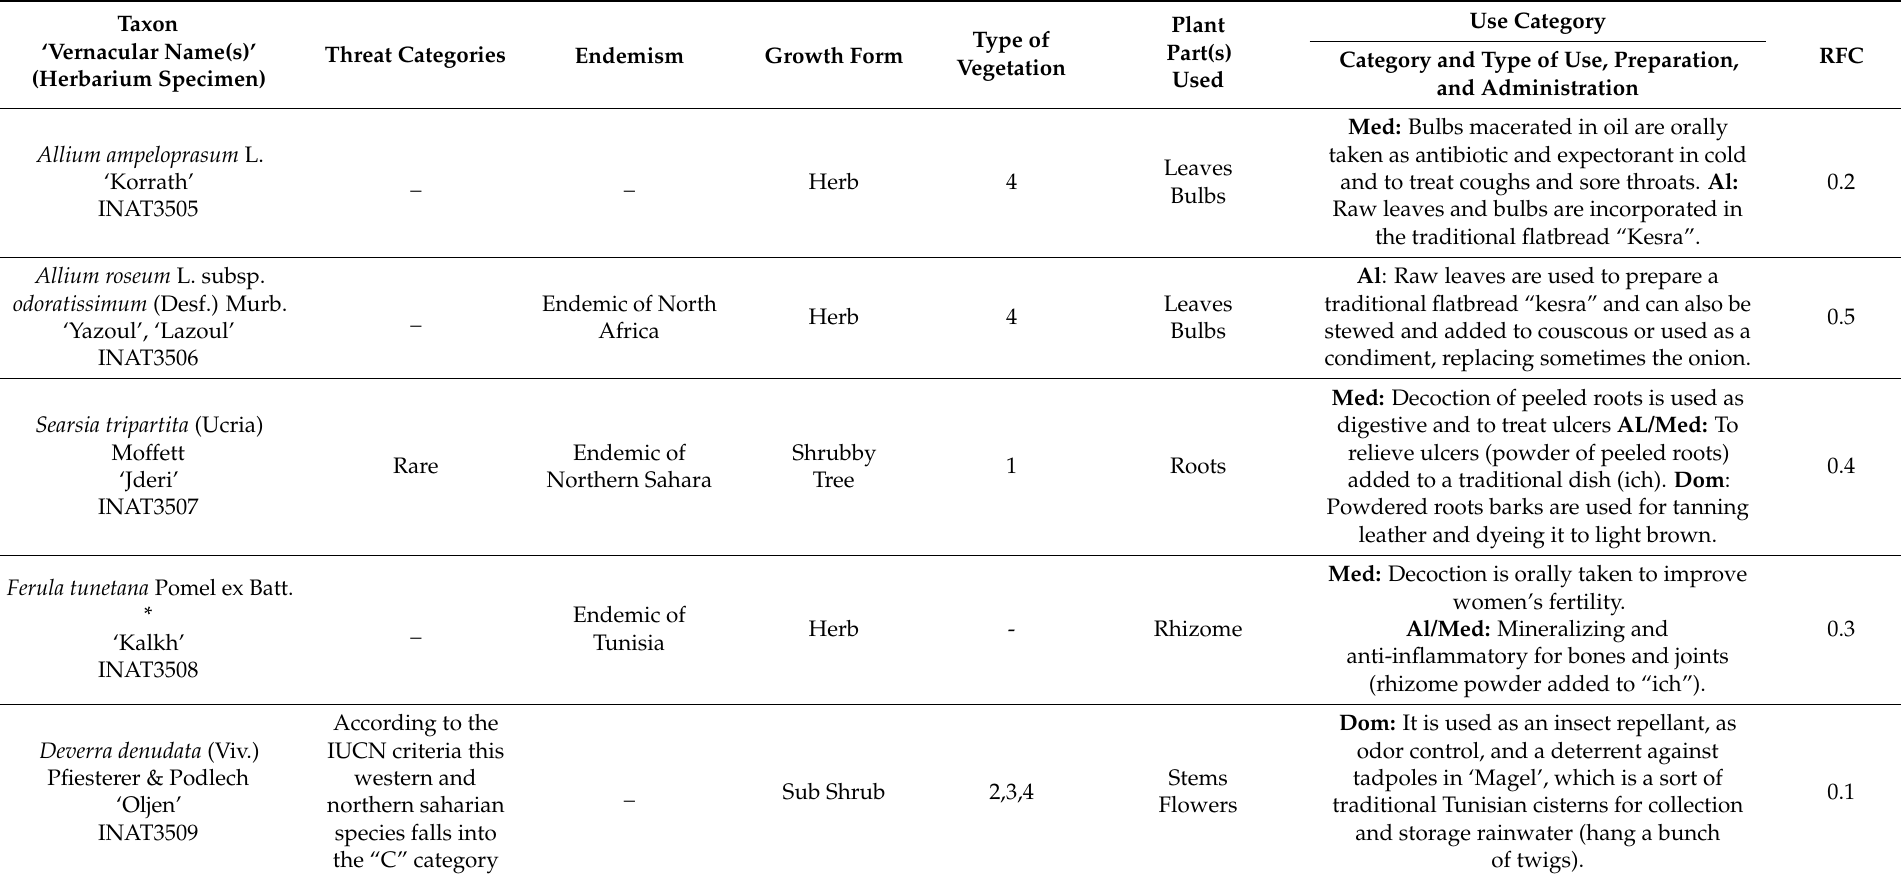
Table 1. Taxa used in Ouled Dabbeb, Southern Tunisia with whole description of their use (family, taxon, vernacular name, hazard categoy, endemism, growth form, habitat, plant part used).